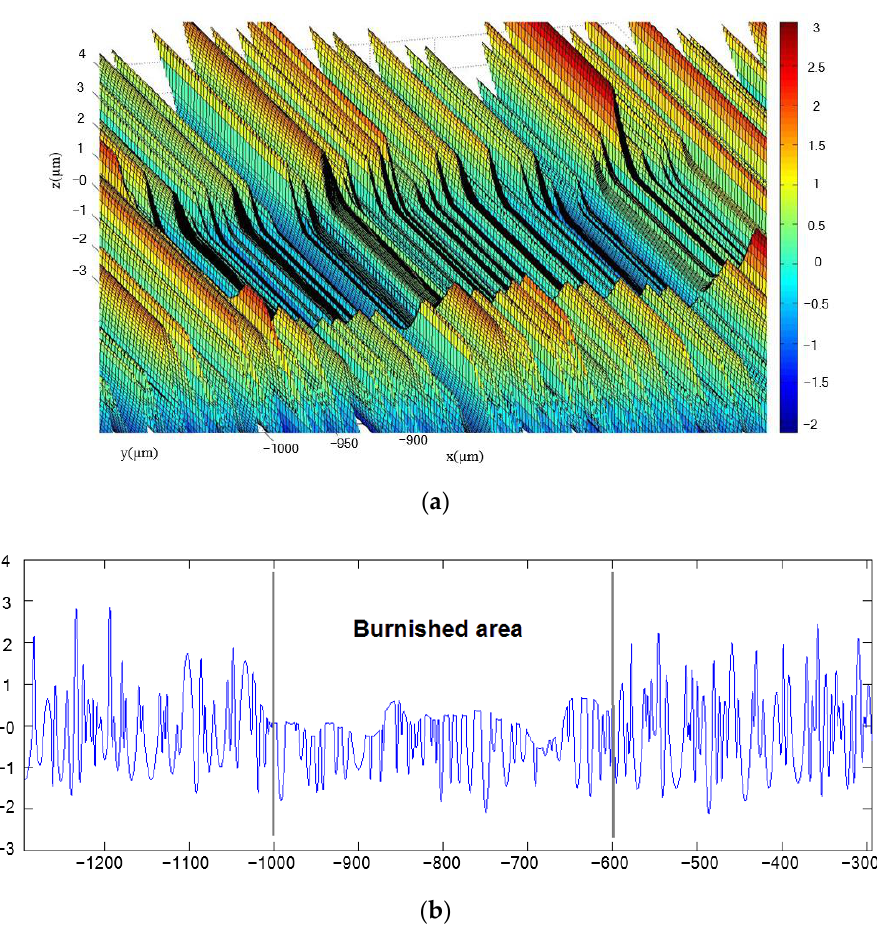
Figure 11. The simulated milled burnished area ( a ) 3D view, ( b ) 2D profile (Polmax material).